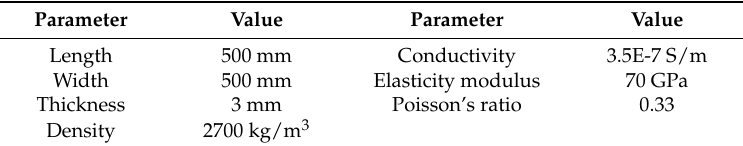
Figure 2. 3D FEM of proposed PPM EMATs for inspecting plates. Table 1. The size and material parameters of the aluminum plate